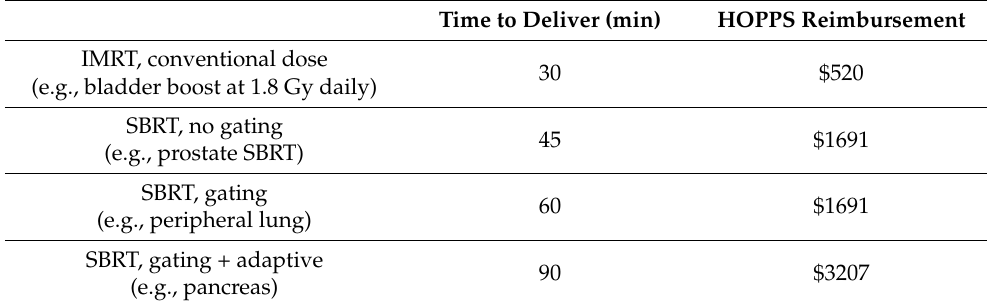
Table 1. HOPPS reimbursement values.